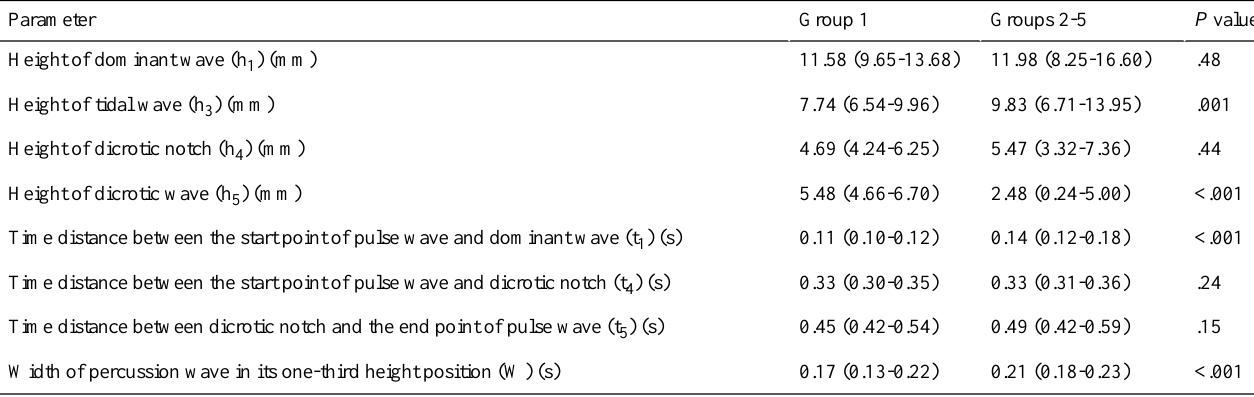
Table 3. Comparison of pulse wave parameters between group 1 and group 2-5.